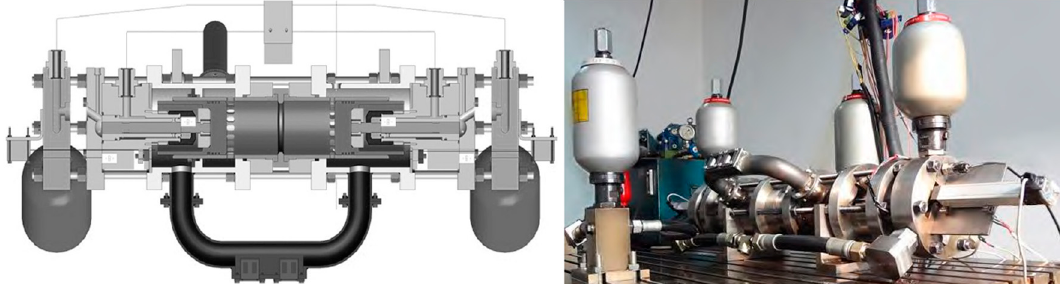
Figure 24. The HFPE of Tianjin University’s Internal Combustion Engine Research Institute [61].